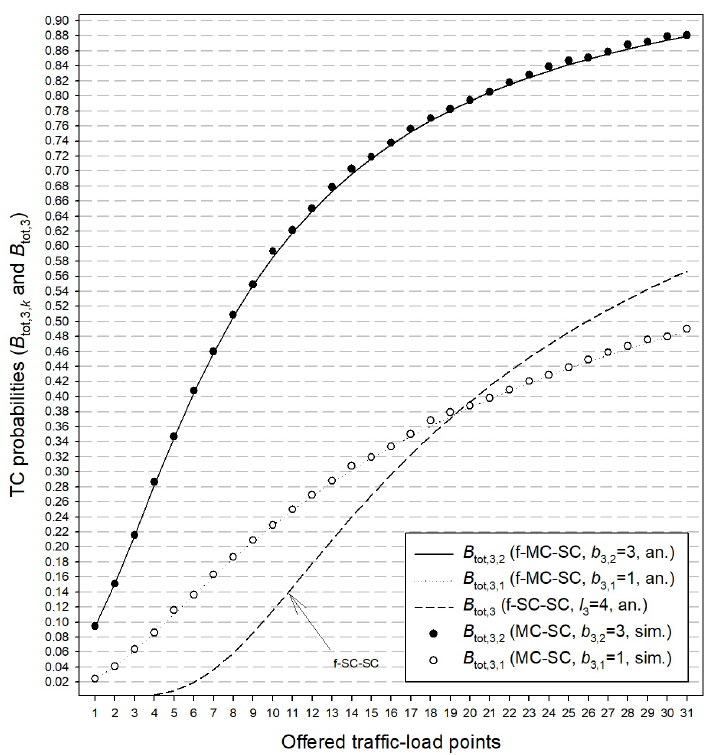
Figure 9. Total TC probabilities (3rd RRH—all service